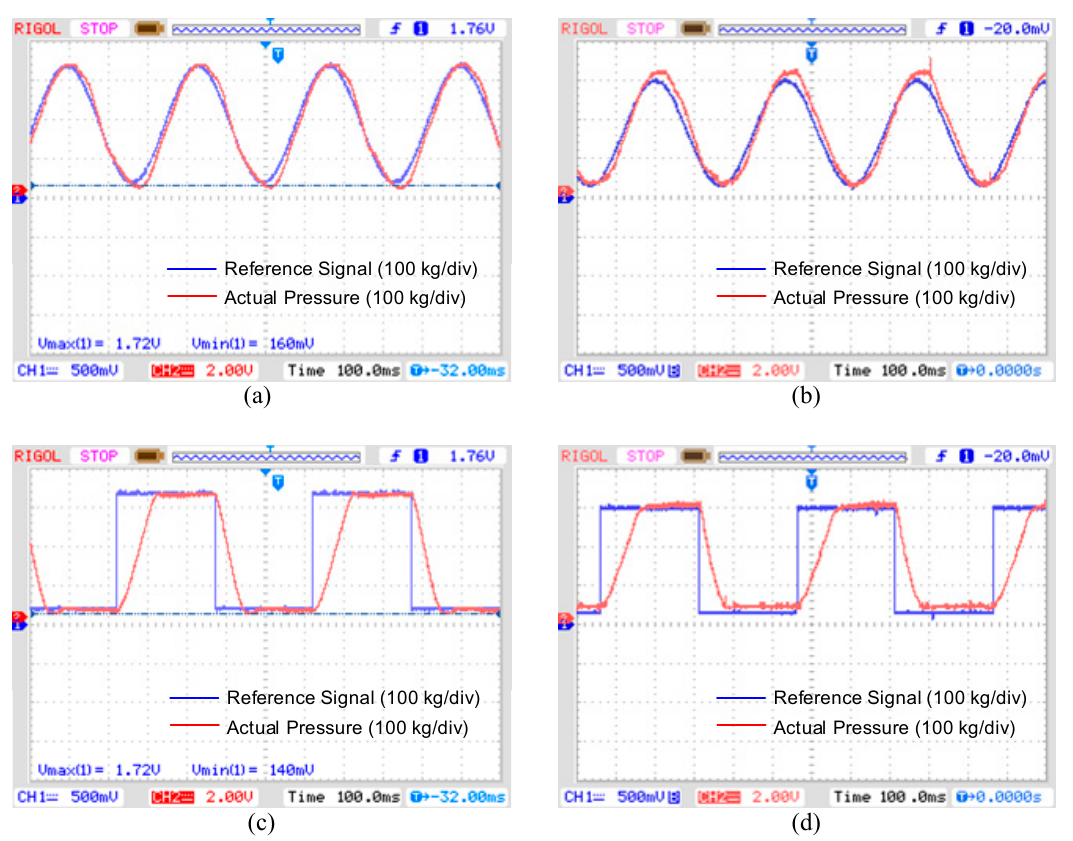
Figure 6. Braking pressure performance comparison. ( a ) Proposed method with a 3 Hz sine wave; ( b ) PID control with a 3 Hz sine wave; ( c ) Proposed method with a 2 Hz square wave; ( d ) PID control with a 2 Hz square wave.